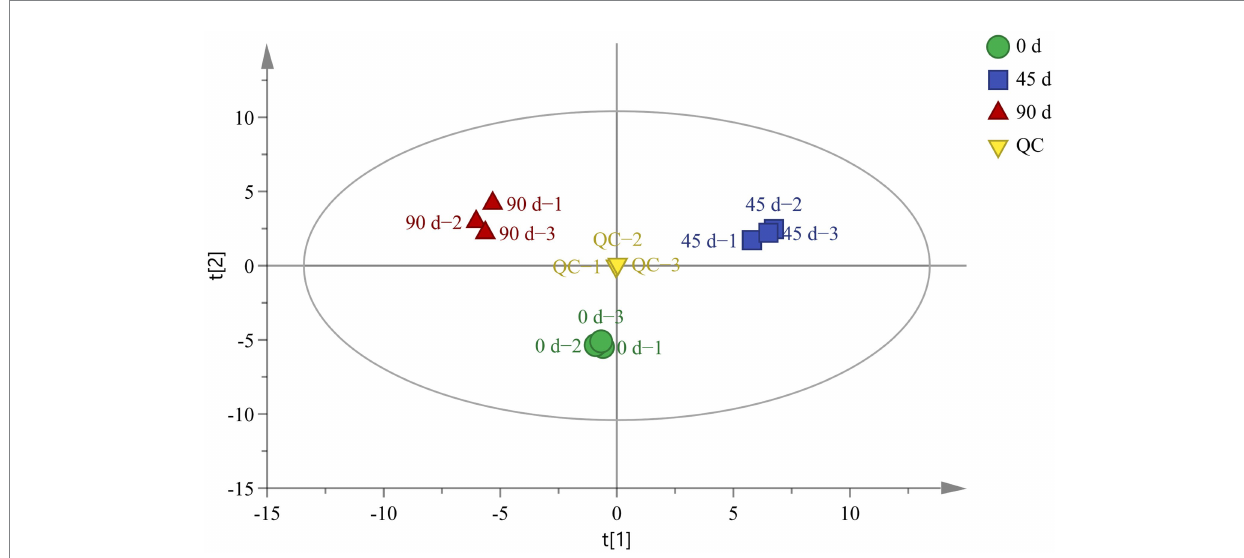
FIGURE 1 Principal component analysis (PCA) scores for LSCKs fermented for 0 days (circle), 45 days (square), and 90 days (regular